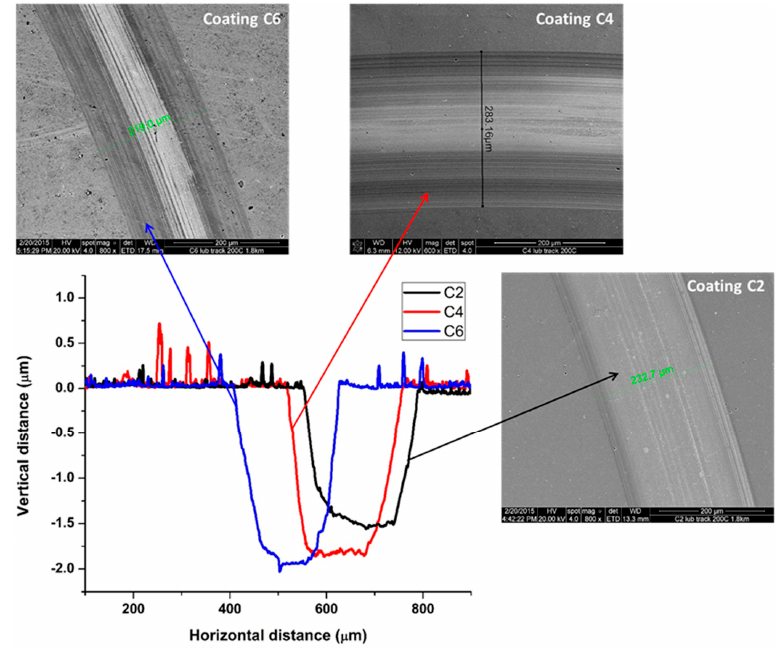
Figure 13. Wear-track profiles of C2, C4 and C6 after lubricated sliding at 200